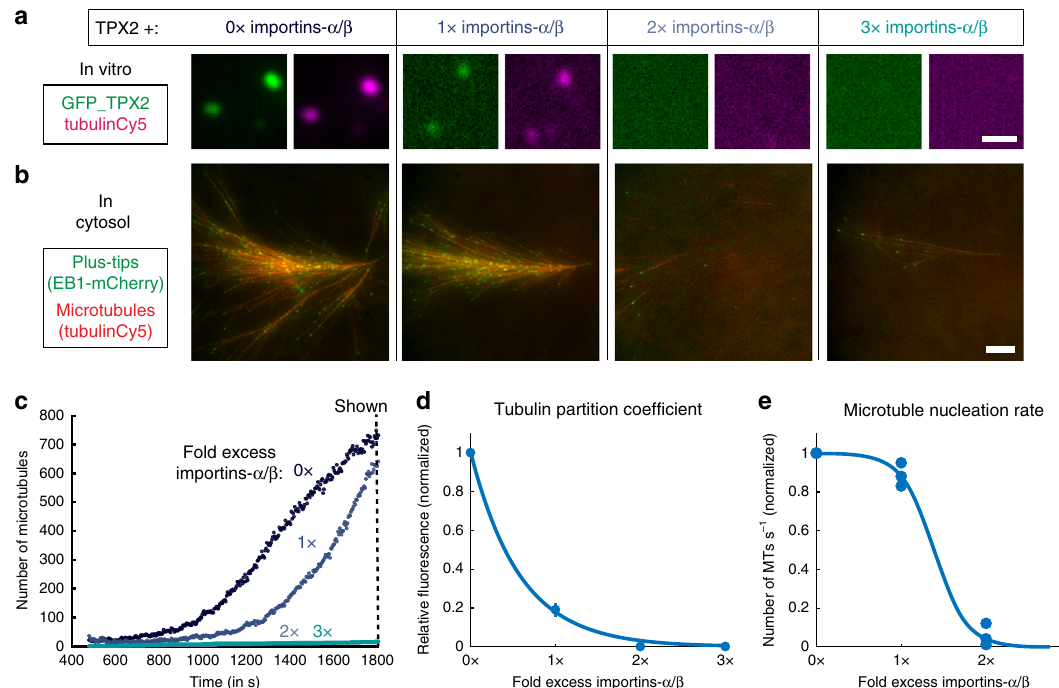
Fig. 6 Importins α / β inhibit TPX2 condensation and activity. a Epi fl uorescent images of TPX2-tubulin co-condensates (green and magenta, respectively) in vitro prepared with importins- α / β at indicated excess (0 × = no importins- α / β ) TPX2 and tubulin both at 500 nM. Scale bar, 1 µ m. b TIRF Images of TPX2-mediated MT nucleation in Xenopus meiotic cytosol with TPX2 and importins- α / β added at 100 nM TPX2 and indicated excess of importins- α / β . Cy5-labeled tubulin (red) and mCherry-EB1 (green) highlight microtubules and growing microtubule plus ends, respectively. Images taken at 1800 s. Scale bar, 10 µ m. See Supplementary Movie 9. c Quanti fi cation of data in b . d Quanti fi cation of relative tubulin signal (partition coef fi cient) as a function of excess importins- α / β . Mean values (points) with ± 1 SD as error bars are shown, n = 522 and 420 condensates for 0× and 1× importins- α / β , respectively. e Rate of MT nucleation as a function of excess importins- α / β , normalized to 0× importins- α / β . Data pooled from three experimental replicates of ( b , c ). Line of best fi t shown. Source data are provided as a Source Data fi le.